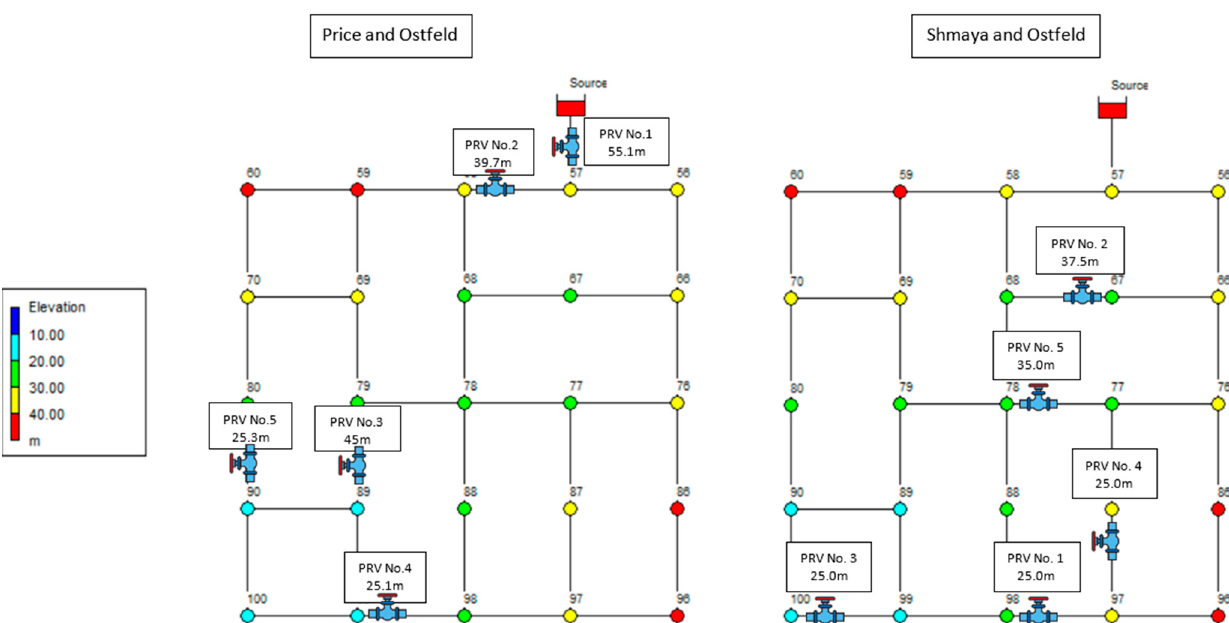
Figure 3. PRV locations and setpoints after applying Price and Ostfeld’s method ( left ) and Shmaya and Ostfeld’s method ( right ) on the synthetic network .